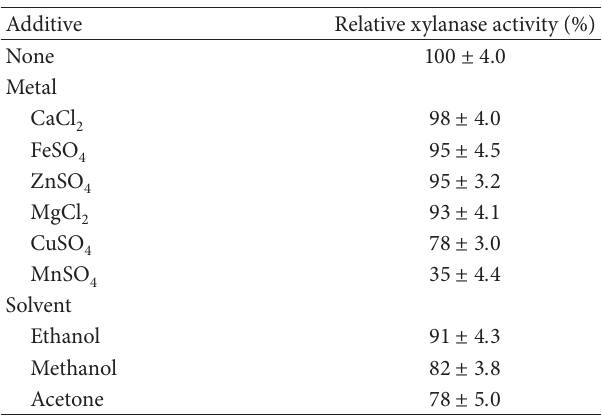
Table 3: Effect of metal ions and solvents on activity of crude xylanase preparation from strain